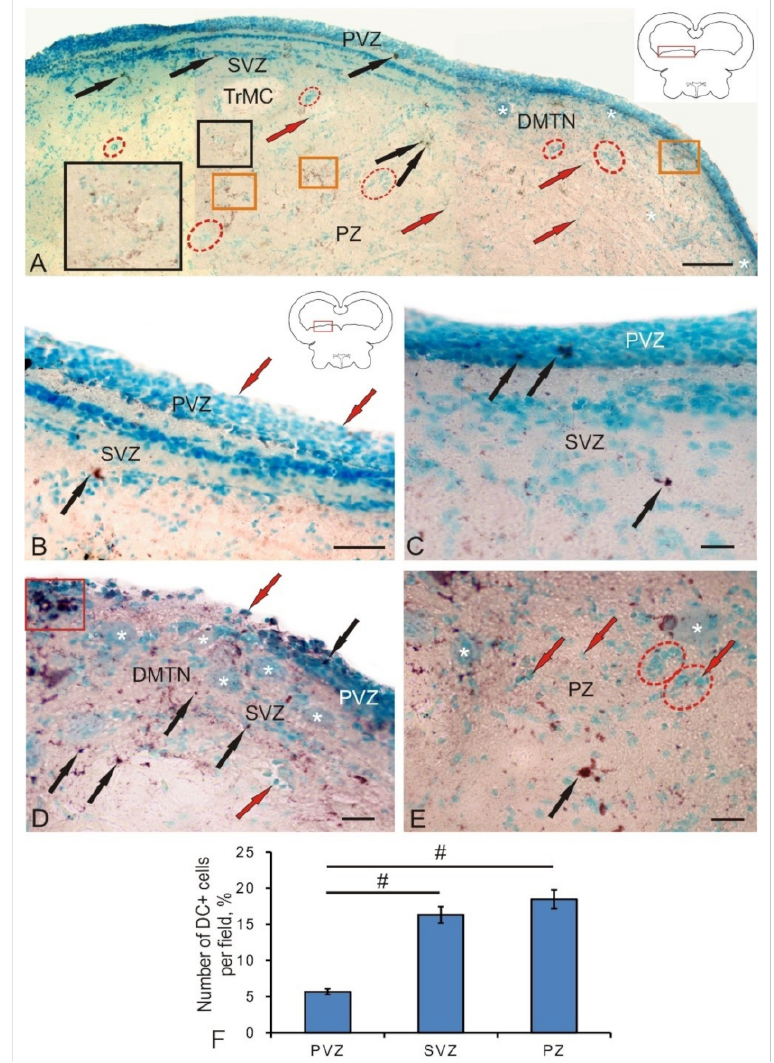
Figure 7. Localization of doublecortin in the mesencephalic tegmentum of juvenile chum salmon, Oncorhynchus keta